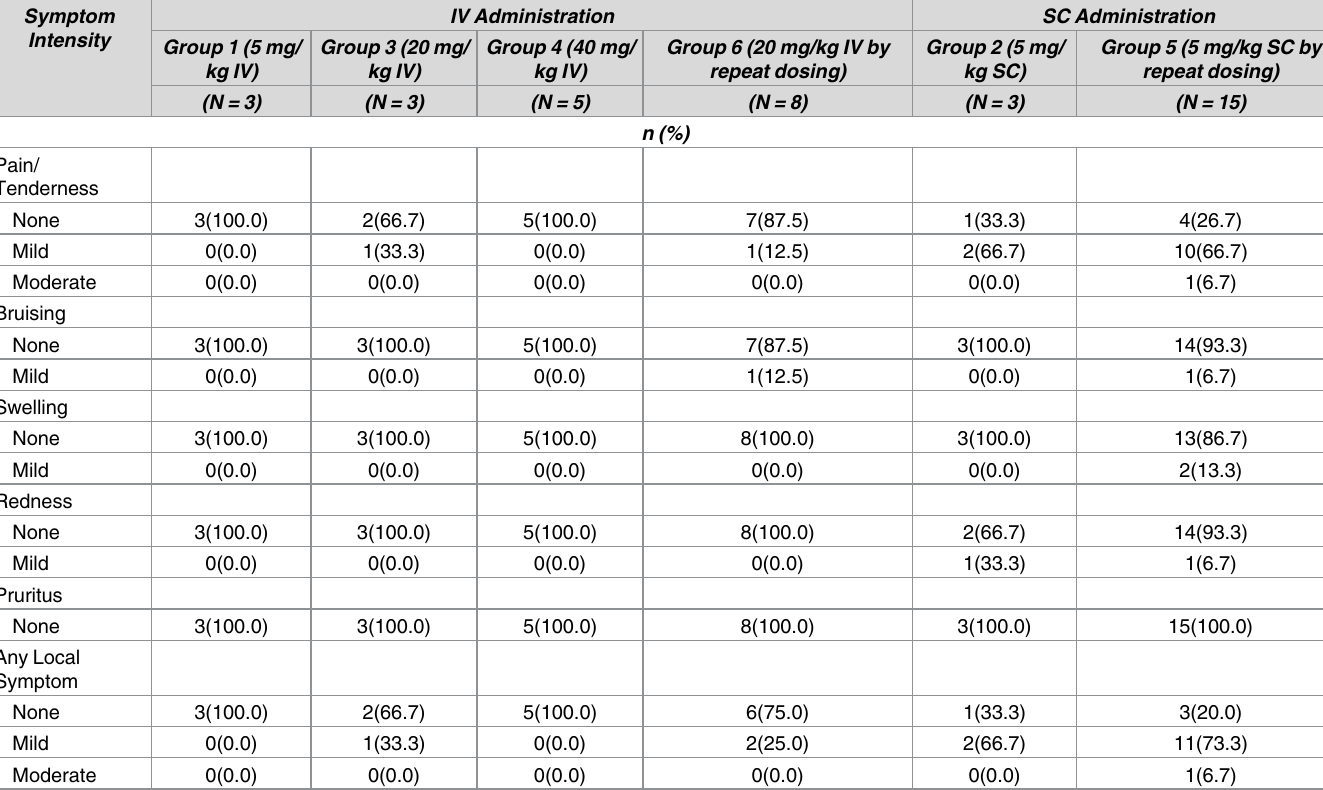
Table 2. Maximum local reactogenicity up to day 7 after VRC01LS administration *